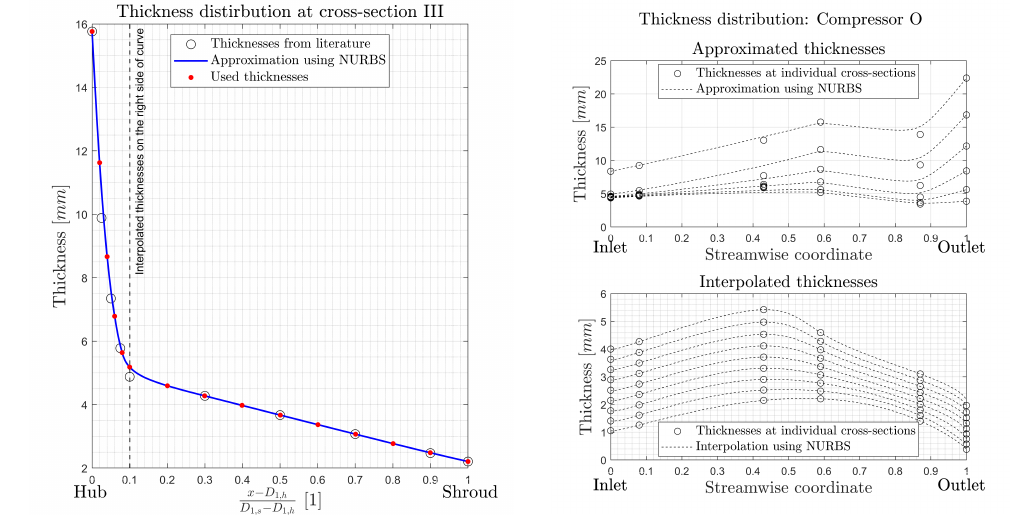
Figure 5. Eckardt type O blade thickness reconstruction: ( left ) Span-wise thickness distribution; ( right ) stream-wise thickness